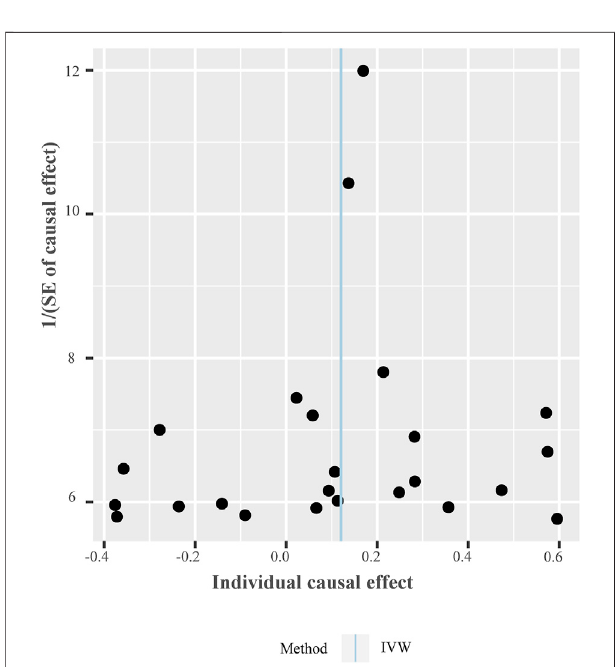
FIGURE5| Funnelplotofindividualcausaleffectbetweenteaintakeand T2D.Causaleffectforeachinstrumentalvariableisdisplayedbytheblackdots to assess potential asymmetry through the funnel plot. Each black dot represents a valid instrumental SNP. The vertical blue line represents the estimated causal effect using all instrumental SNPs from IVW methods. Abbreviations: IVW, inverse variance-weighted method; SNPs, single- nucleotide